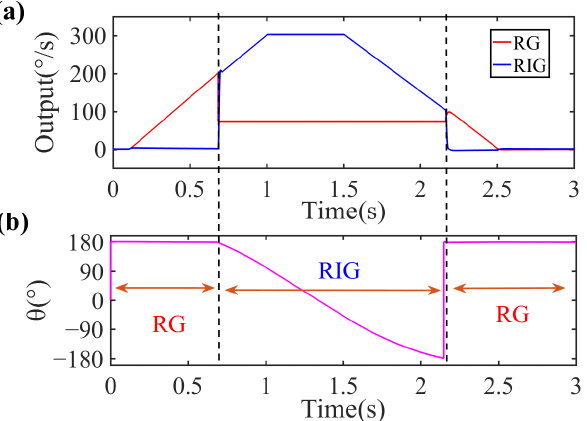
Figure 5. ( a ) Angular rate and ( b ) precession angle simulation results during automatic mode switching.